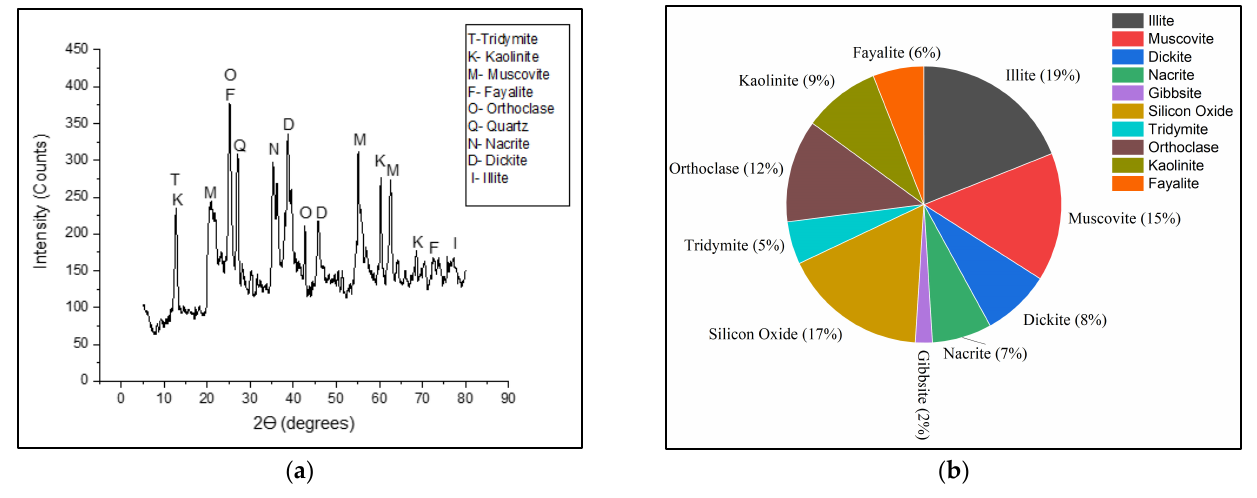
Figure 22. Characterization of minerals and compounds; ( a ) XRD analysis of Byndoor sample, ( b ) quantification of compounds.